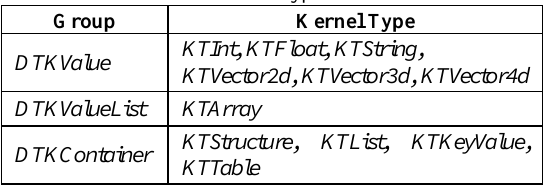
Table 1 Kernel type of